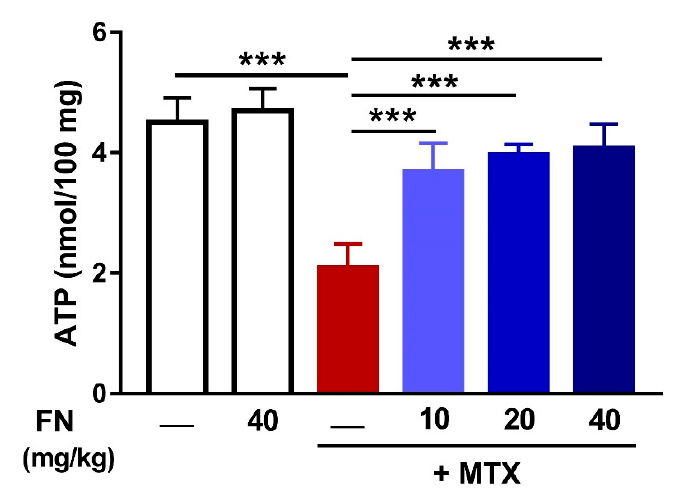
Figure 5. FN increases renal adenosine triphosphate (ATP) levels in MTX-induced rats. Data are mean ± SEM, ( n = 6). *** p <